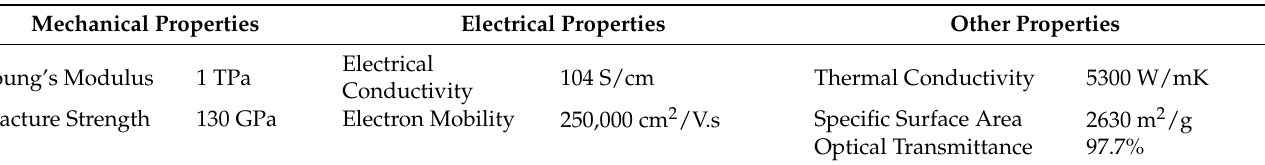
Table 1. Mechanical and functional properties of graphene